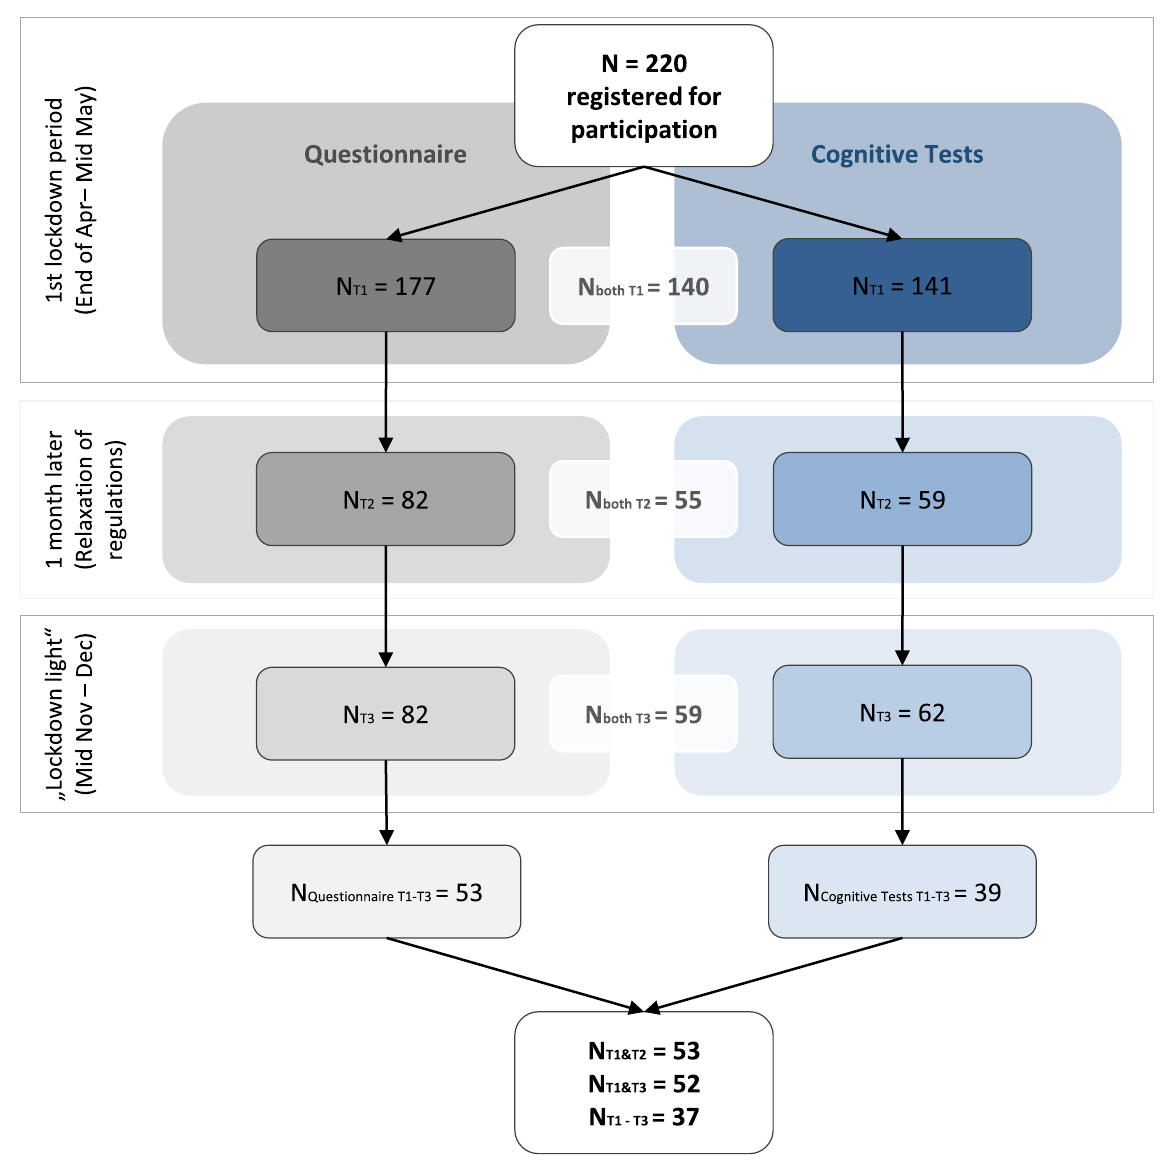
Figure 7. Flow Chart of Participants and dropouts over the three assessments for the questionnaire on SoSci Survey as well as the online-based cognitive tasks with MyBrainTraining. From the 220 registered participants, 196 took part in at least one measurement time point and completed at least one task. As the questionnaire and the cognitive tasks could be completed independently, the number of participants differs for the questionnaire and cognitive tasks across time points. As such, 140 participants in the first assessment finished the questionnaire as well as the cognitive tasks (94 females). The age of this initial sample ranged from 20 to 77 years ( mean age = 43.53, SD age = 15.94). In the second assessment 55 participants completed both the questionnaire and the cognitive tasks (40 females, mean age = 44.05, SD age = 17.05). In the third assessment, 59 participants finished both tasks (40 females, mean age = 44.90, SD age = 16.60). Overall, 37 participants completed all three assessments. The analyzed sample of 51 participants who finished both assessments in T1 and T3 included 12 students, 11 retirees and 28 employed